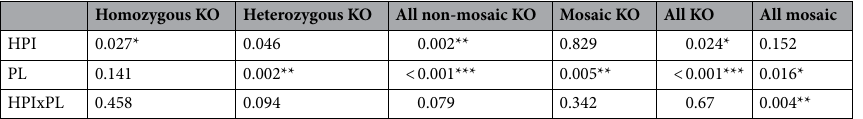
Table 2. Factor analysis of editing outcomes. Analysis of effect of experimental factors on knockout type: GLMM of HPI, pulse length and their interaction on rate of homozygous, heterozygous and mosaic knockouts. Values are p values of each factor for each variable. *, ** and *** denote p values < 0.05, < 0.01 and < 0.001, respectively.